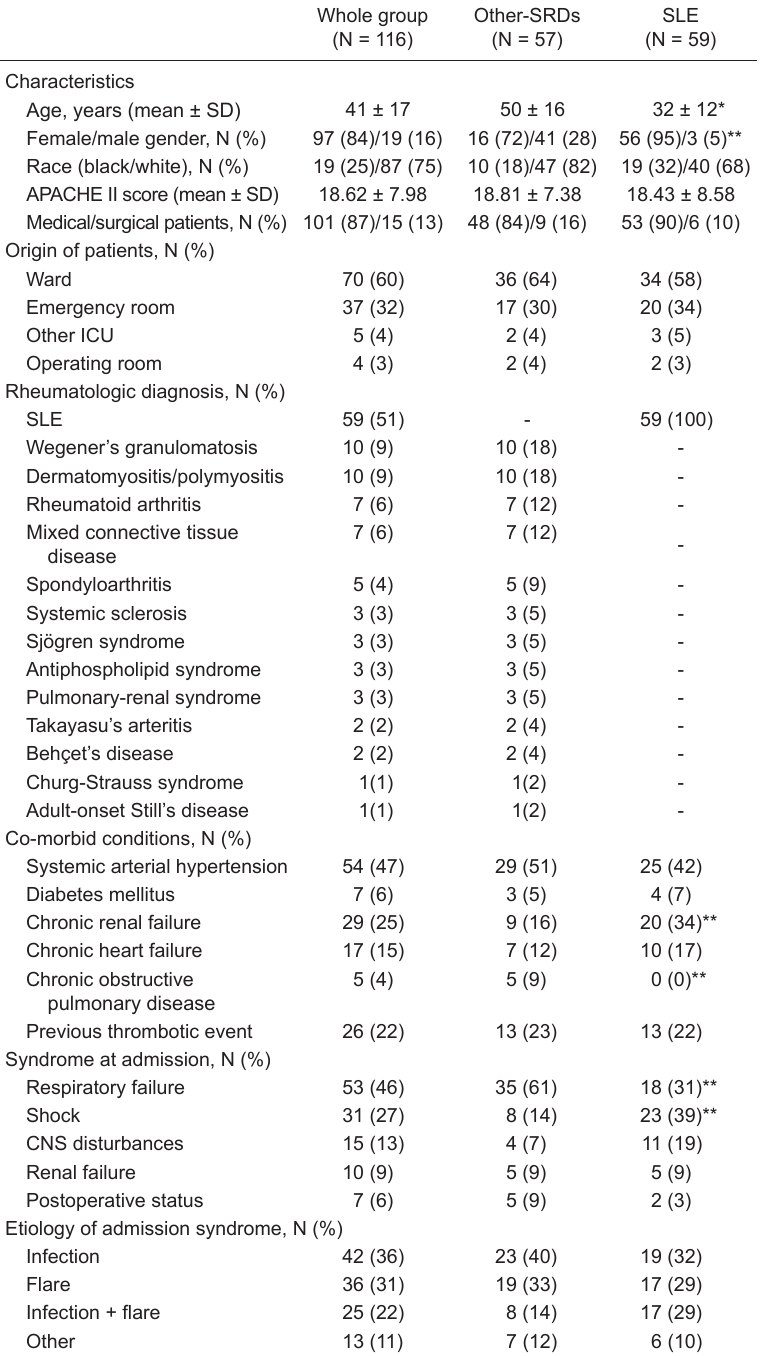
Table 1. Characteristics of all patients at